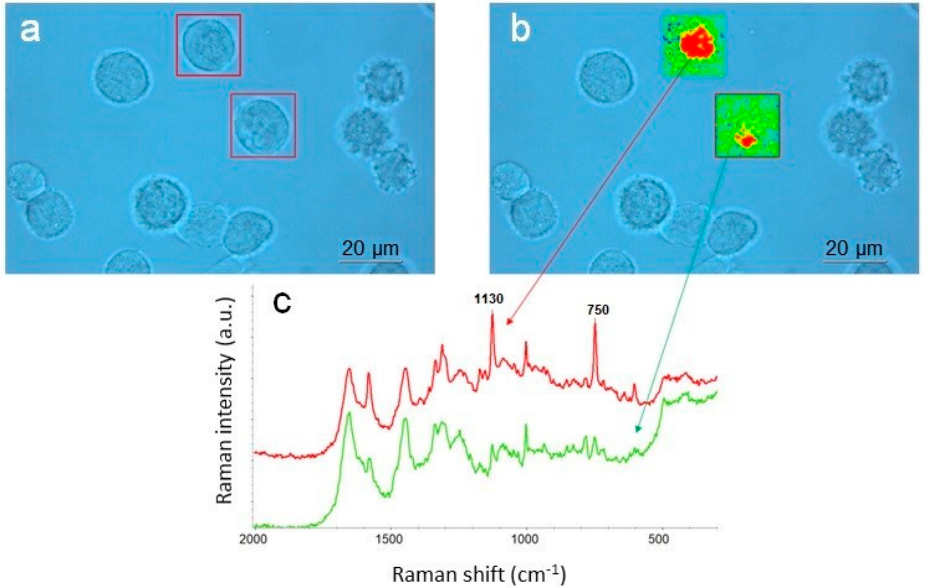
Figure 5. Probing cytochrome C in cancerous cells with resonance Raman using 532 nm excitation: ( a ) optical image captured with 60 × water immersion (WI) objective; ( b ) Raman images of two cells generated as integral intensities of the resonantly enhanced peak at 1130 and 750 cm − 1 and superimposed on the optical image; ( c ) representative average Raman spectra of the cytochrome C (red) and the rest of the cell (green)—the spectra are offset for clarity. Measurement parameters: 8 mW of the 532 nm laser power at the sample, 50 µ m confocal pinhole, 1 µ m image pixel, 925 spectra, 7 min total collect